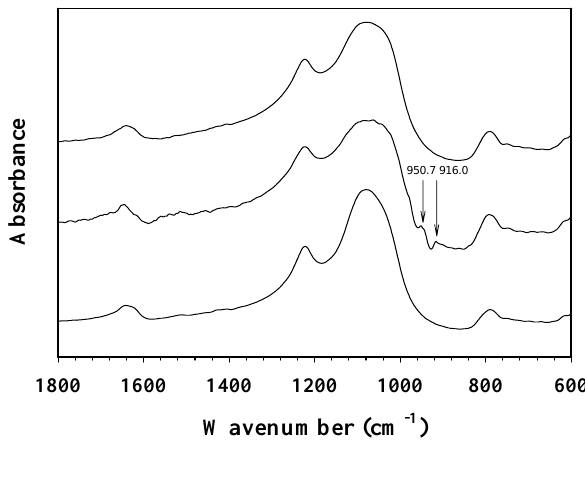
Figure 10. FT-IR spectra of NaZSM-5(23); A before; B during; C after NH (28 ± 1) °C and at 1